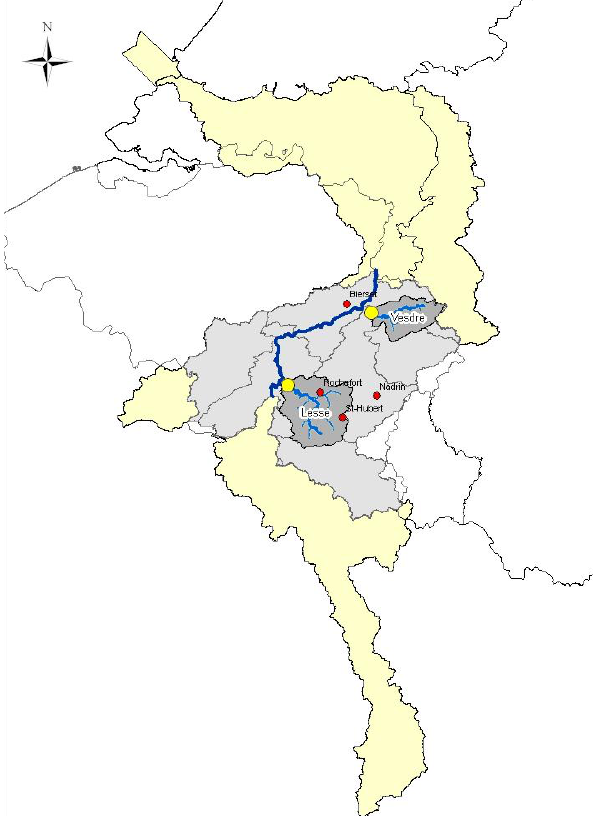
Fig. 1. The Meuse catchment (light grey) in Wallonia (Belgium) and the Vesdre and the Lesse catchments (dark